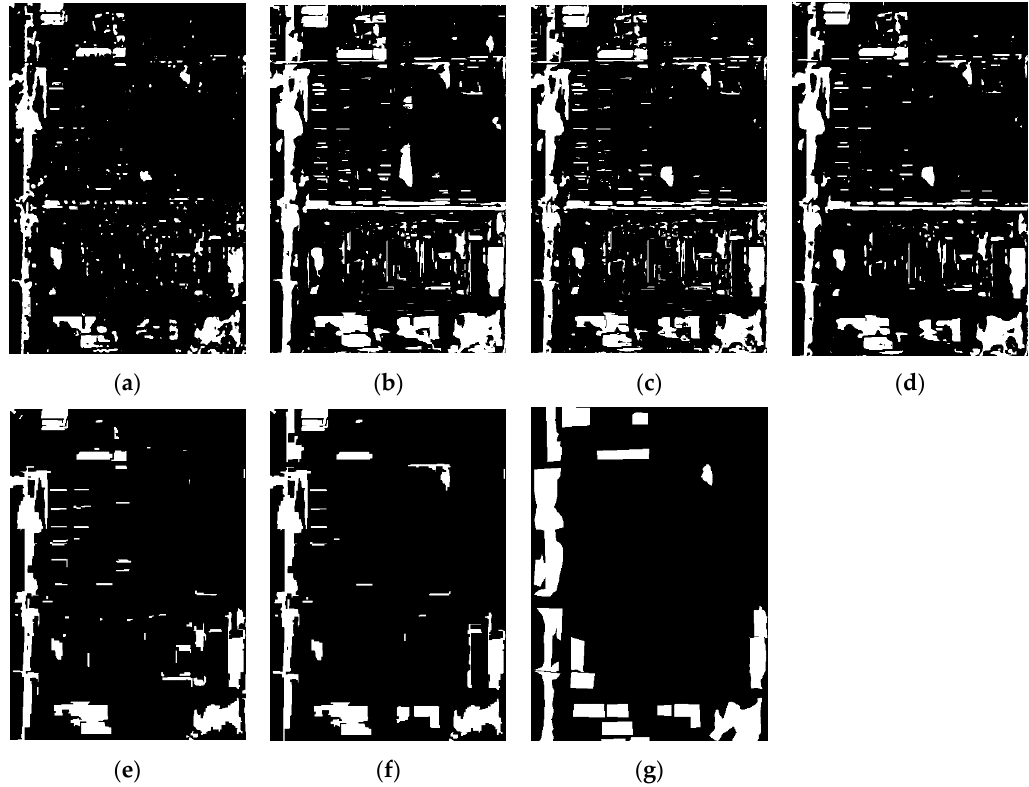
Figure 12. CD maps generated by different CD methods: ( a ) DRLSE; ( b ) CV; ( c ) MLSK; ( d ) EMAC; ( e ) OBCD; ( f ) SDCDUA; ( g ) reference map.